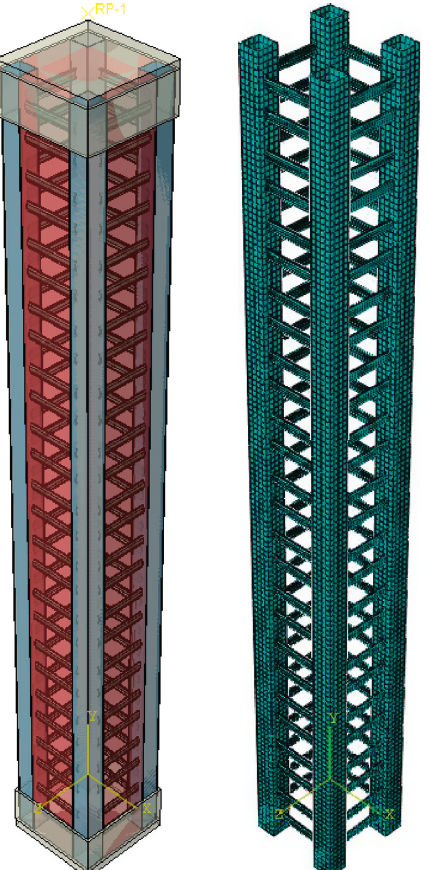
Figure 7: Mesh diagram of the FE model.